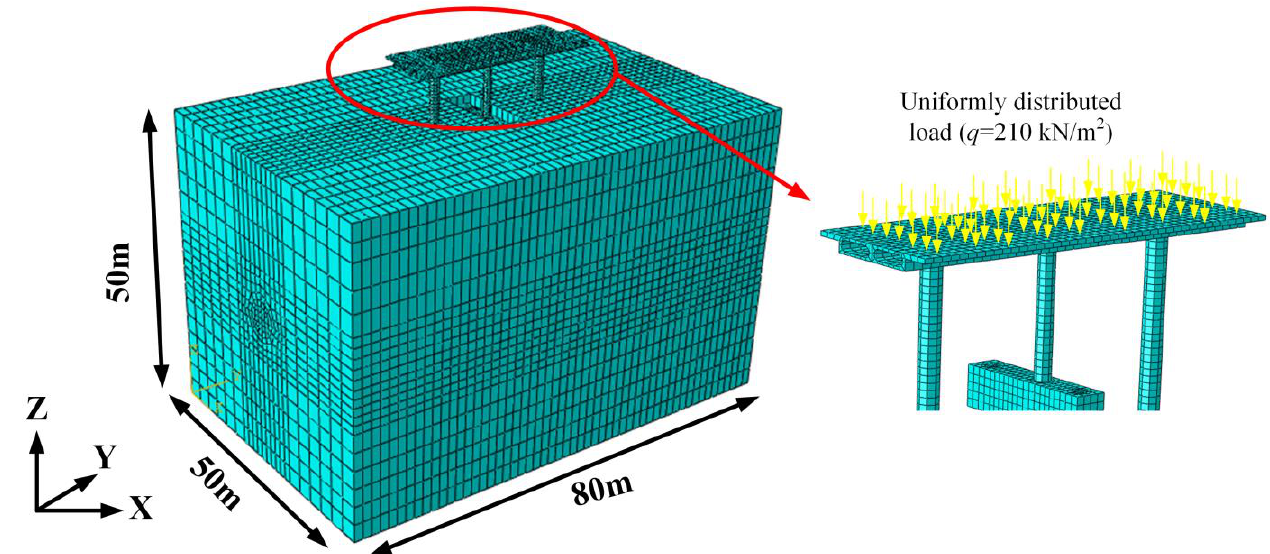
Figure 4. 3D-FEM modelling configuration and boundary conditions.